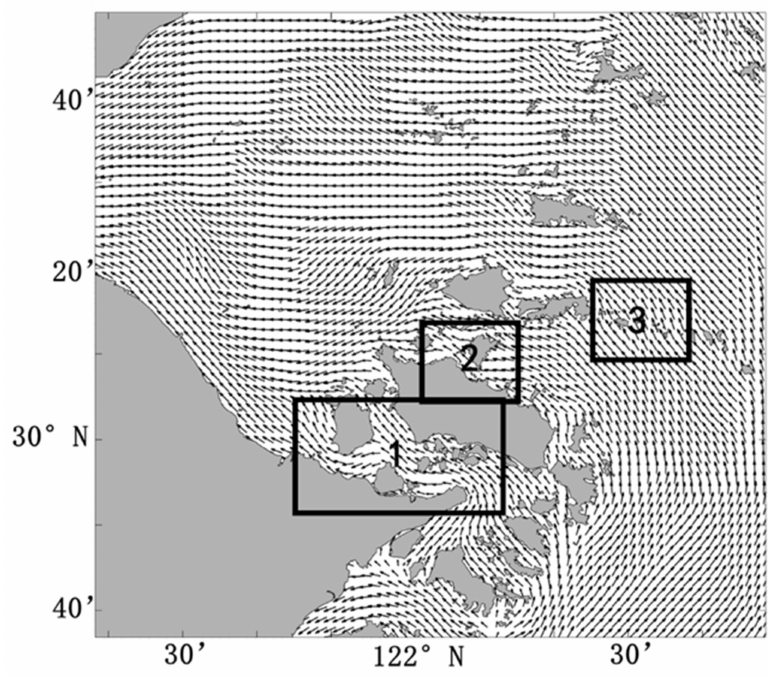
Figure 4. The MFD in Zhoushan Islands. Solid boxes show the regions